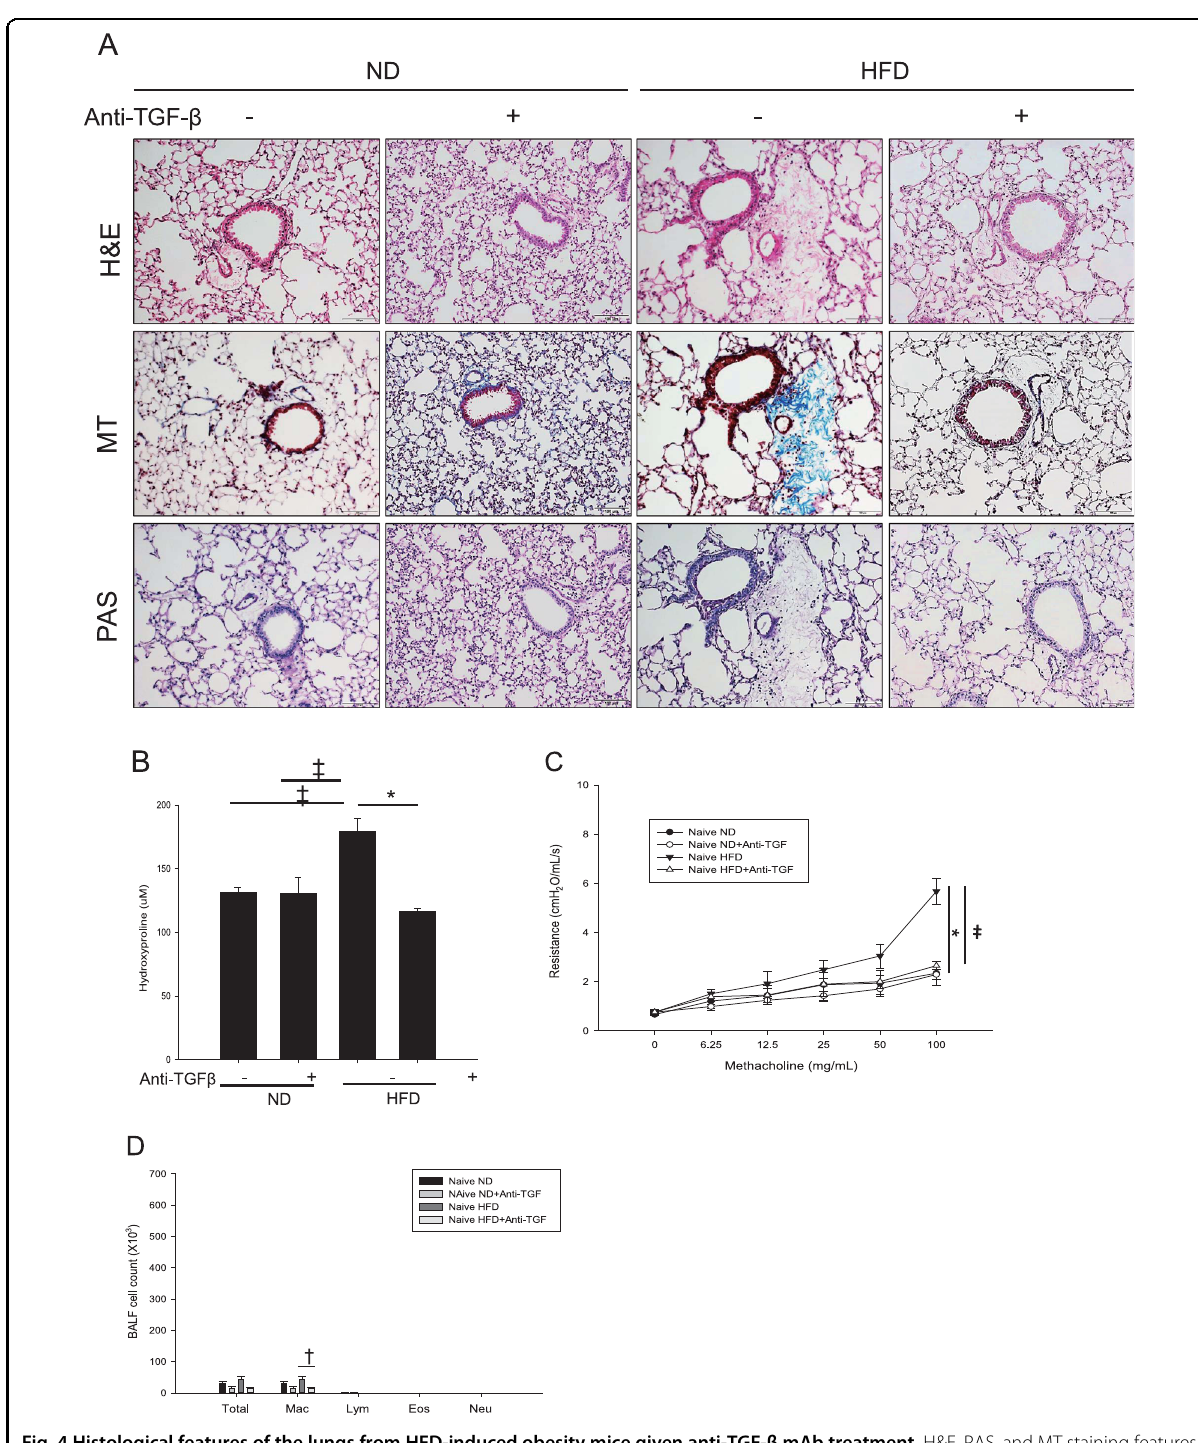
Fig. 4 Histological features of the lungs from HFD-induced obesity mice given anti-TGF- β mAb treatment. H&E, PAS, and MT staining features ( a ) are shown at ×200 magni fi cation. The collagen content of the lung tissue was measured by a hydroxyproline assay ( b ). Panels 4c, d show the effects of anti-TGF- β mAb treatment on AHR to MCh ( c ) and the in fl ammatory cell pro fi le of the BALF ( d ) in naive HFD mice compared with naive ND mice. ‡ P < 0.01, * P < 0.001. HFD high-fat-diet, ND normal diet, TGF transforming growth factor, H&E hematoxylin and eosin, PAS periodic acid-Schiff, MT Masson ’ s